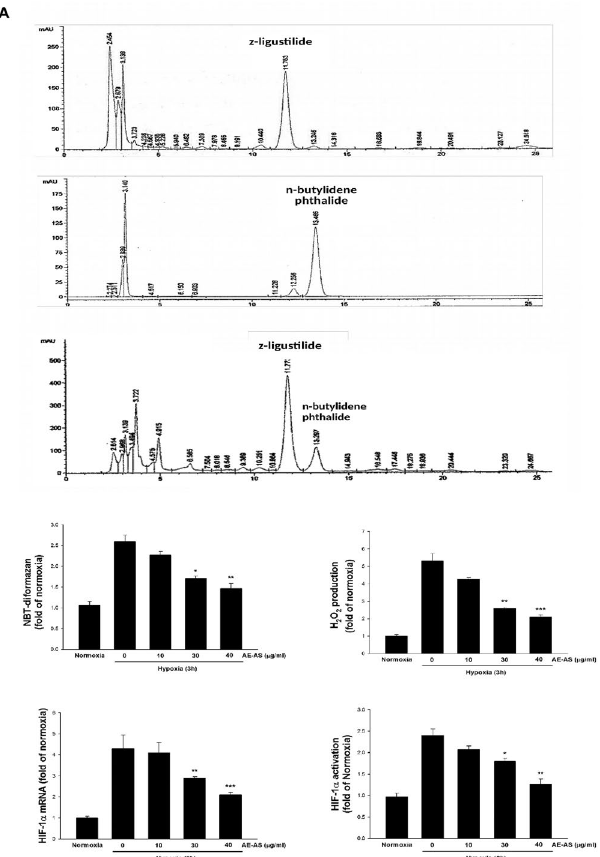
Figure 1. AE-AS inhibited ROS formation, HIF-1 α mRNA expression and activation in hypoxic T24